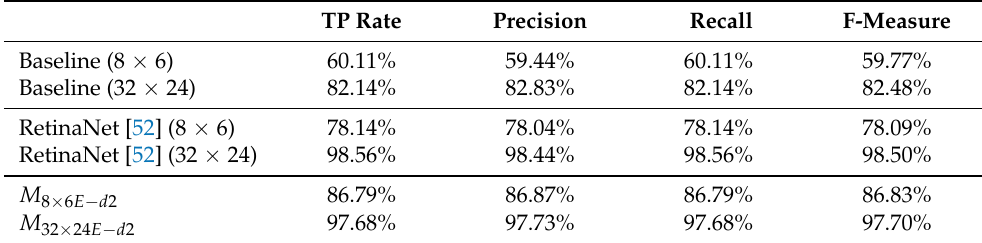
Table 13. The classification TP rate, precision, recall, and F1-score of the proposed method vs. the conventional ones. TP Rate Precision Recall